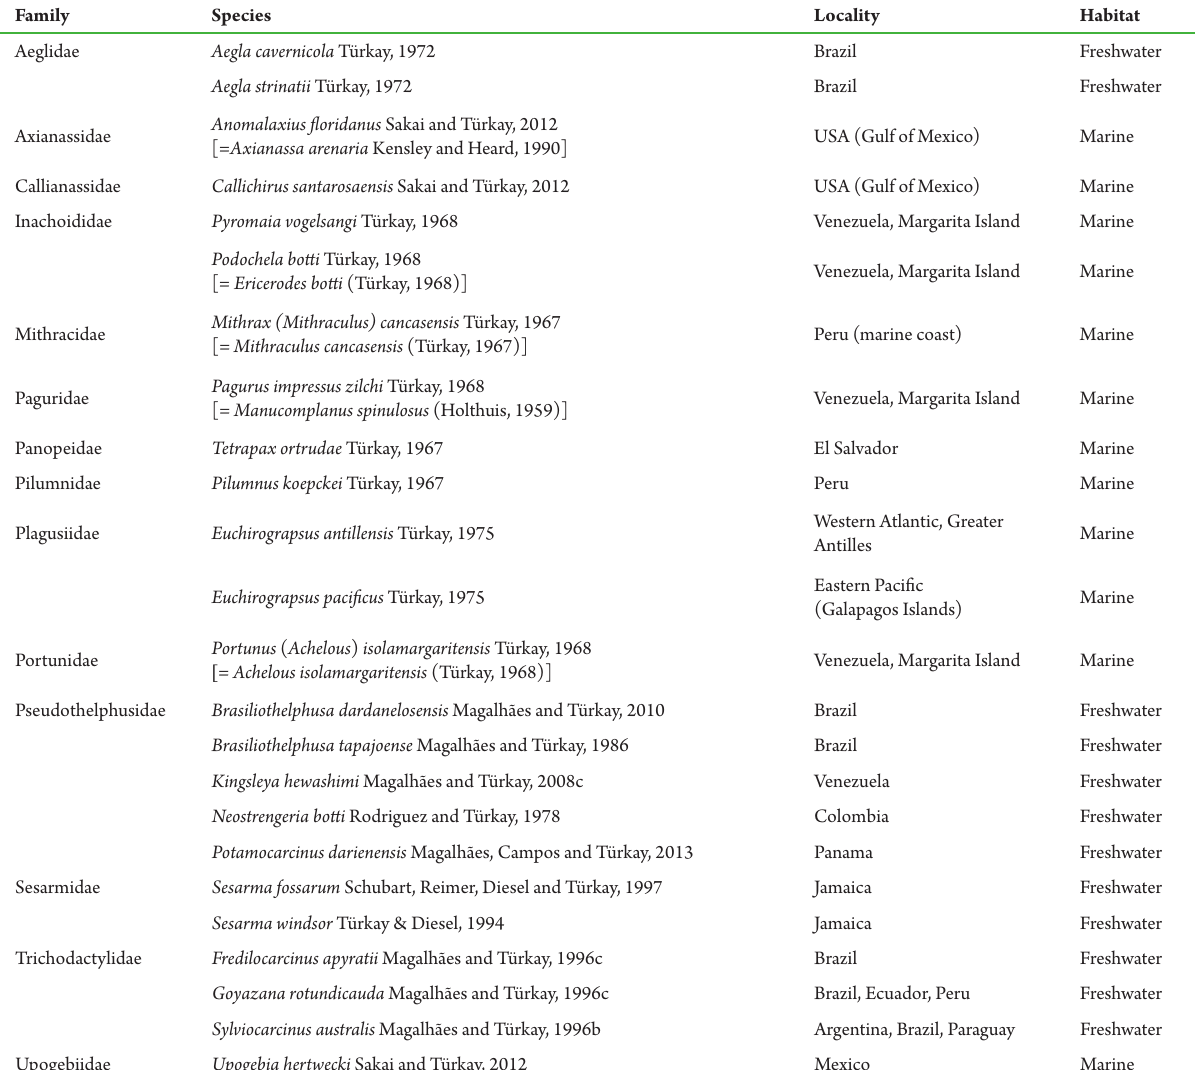
Table 2. Species of New World decapod crustaceans described by Michael